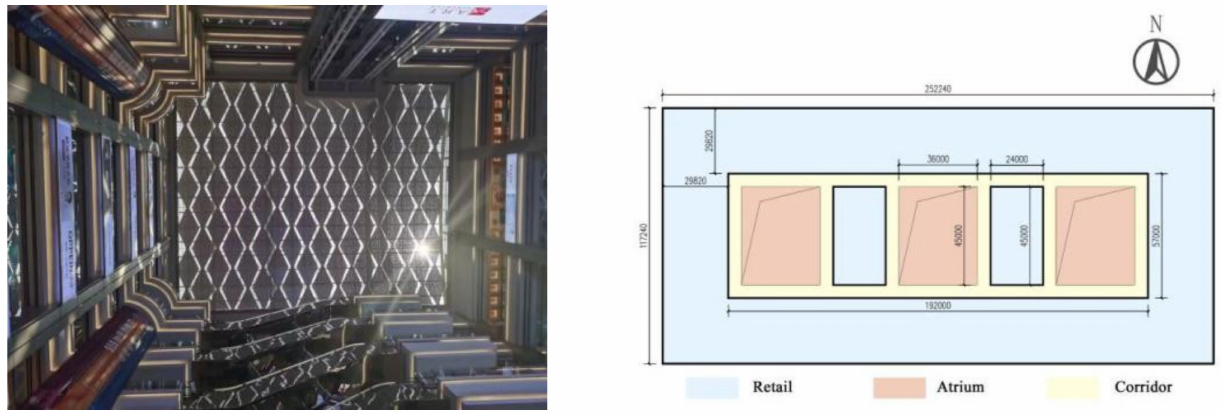
Figure 3. Atrium photo and floor plan diagram (Author self photography).